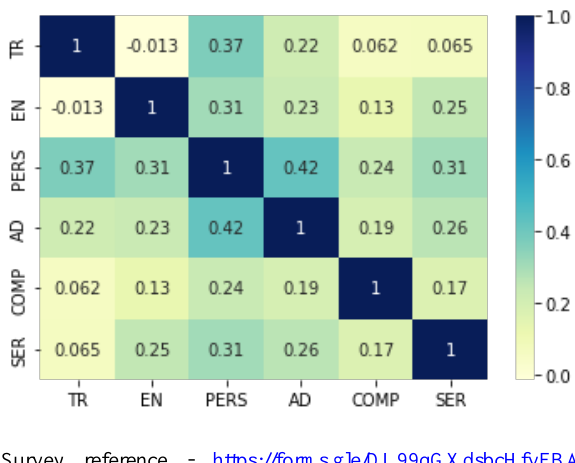
Table 6 . Constructs Correlation